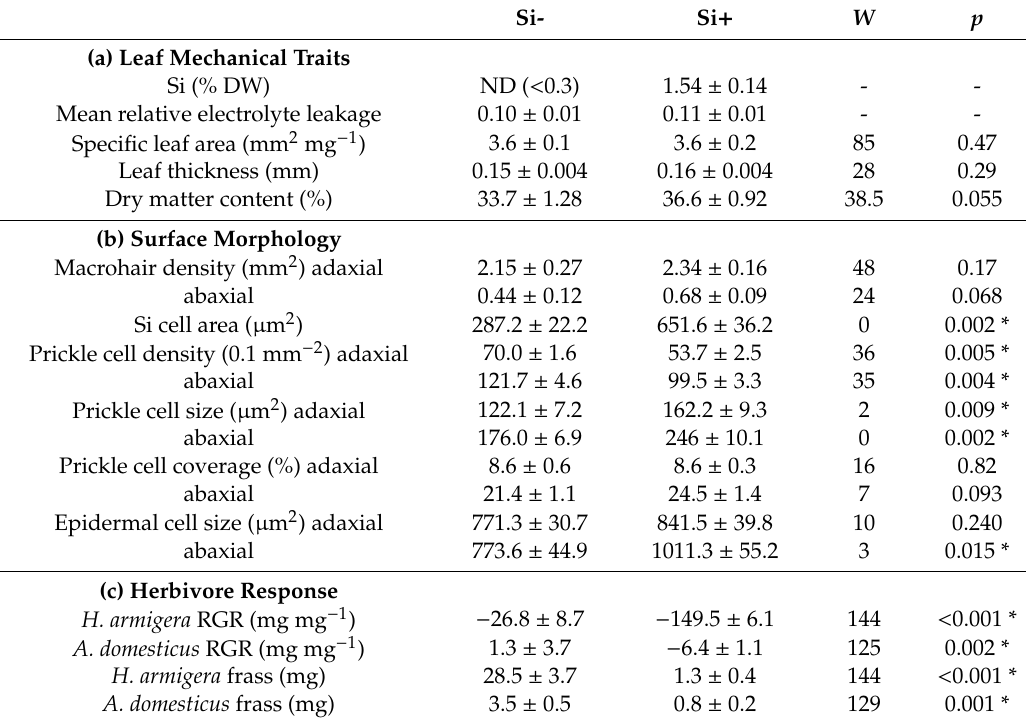
Table 1. Mann–Whitney–Wilcoxon results of the effect of Si on leaf traits and herbivore responses. Values are means ± standard error ( n = 6–12).